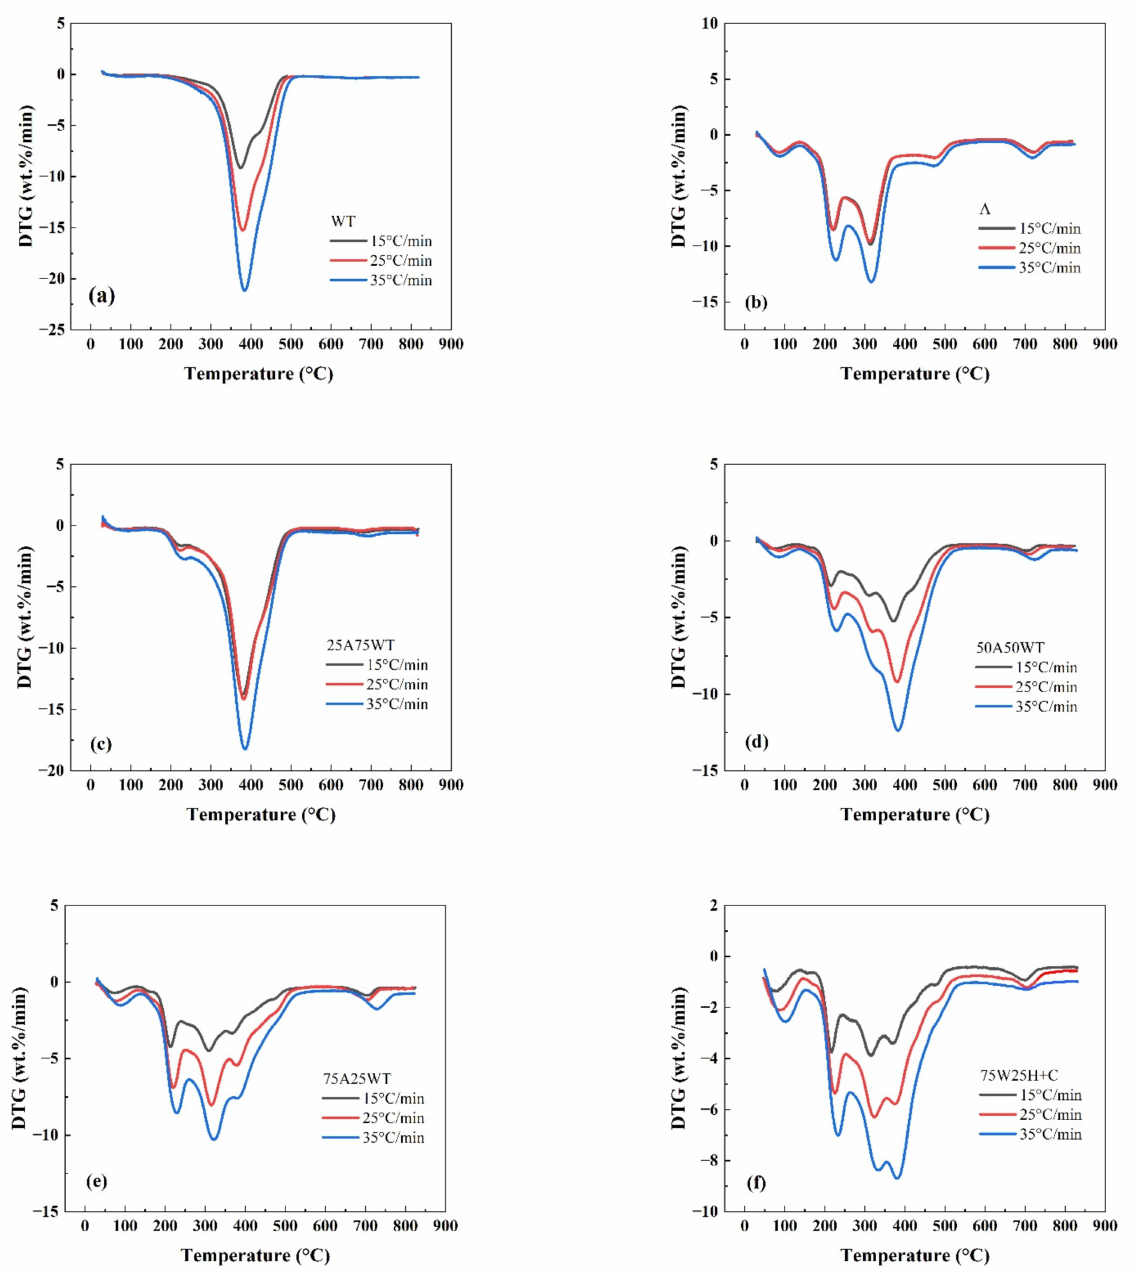
Figure 2. DTG curves of ( a ) WTS, ( b ) AP, and ( c – f ) their blends at three different heating rates. It can be seen that the pyrolysis process can be divided into four stages [33]: (1) the drying and dehydration stage (50–150 ◦ C), where the water in the sample evaporates; (2) the devolatilization stage (130–260 ◦ C) where the volatile matter in the sample is removed, and the hemicellulose in the sample plant is thermally decomposed; (3) the combustion stage (250–430 ◦ C) where the cellulose and lignin with larger molecular weight in the sample are thermally decomposed, and the reaction rate decreases with the increase in temperature; and (4) the residual calcination stage ( ≥ 400 ◦ C) where the lignin in the sample undergoes subsequent calcination. This sequence of pyrolysis stages is consistent with the conclusion of [34], which states that hemicellulose begins to decompose around 200–350 ◦ C, and cellulose begins to decompose around 350–400 ◦ C. In the case of WTS, one decomposition step was observed, with a sharp peak at 379.5 ◦ C, which is attributed to the decomposition of natural rubber (polyisoprene, NR)